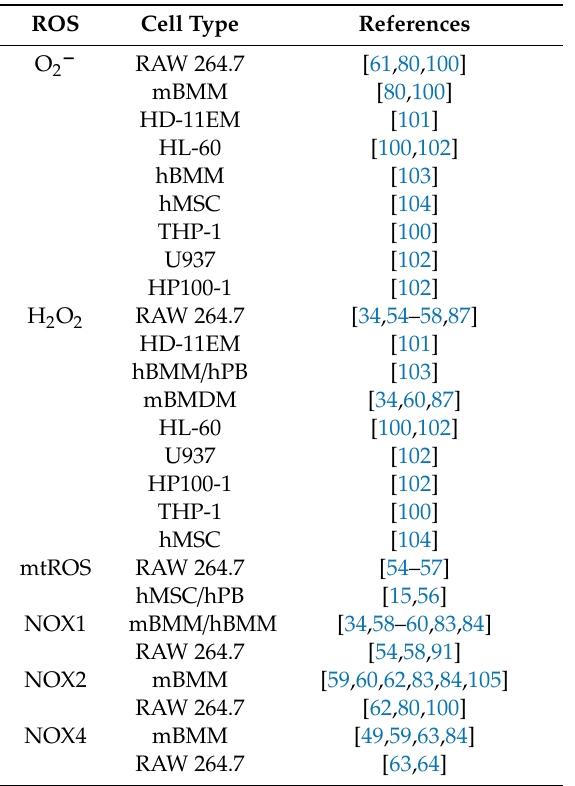
Table 1. ROS in osteoclasts.